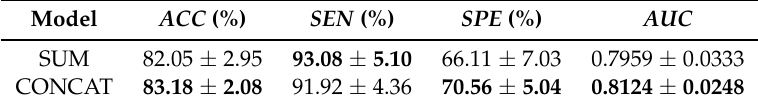
Table 11. Classification performance of different combination methods for T2 task.